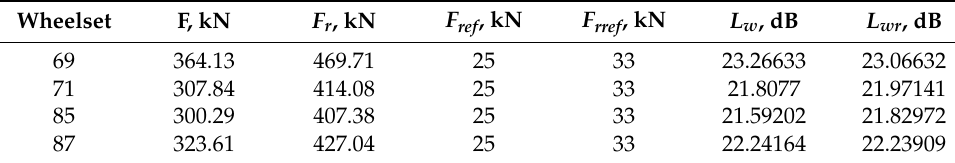
Table 8. Corrected results for the theoretical sound power change calculation.